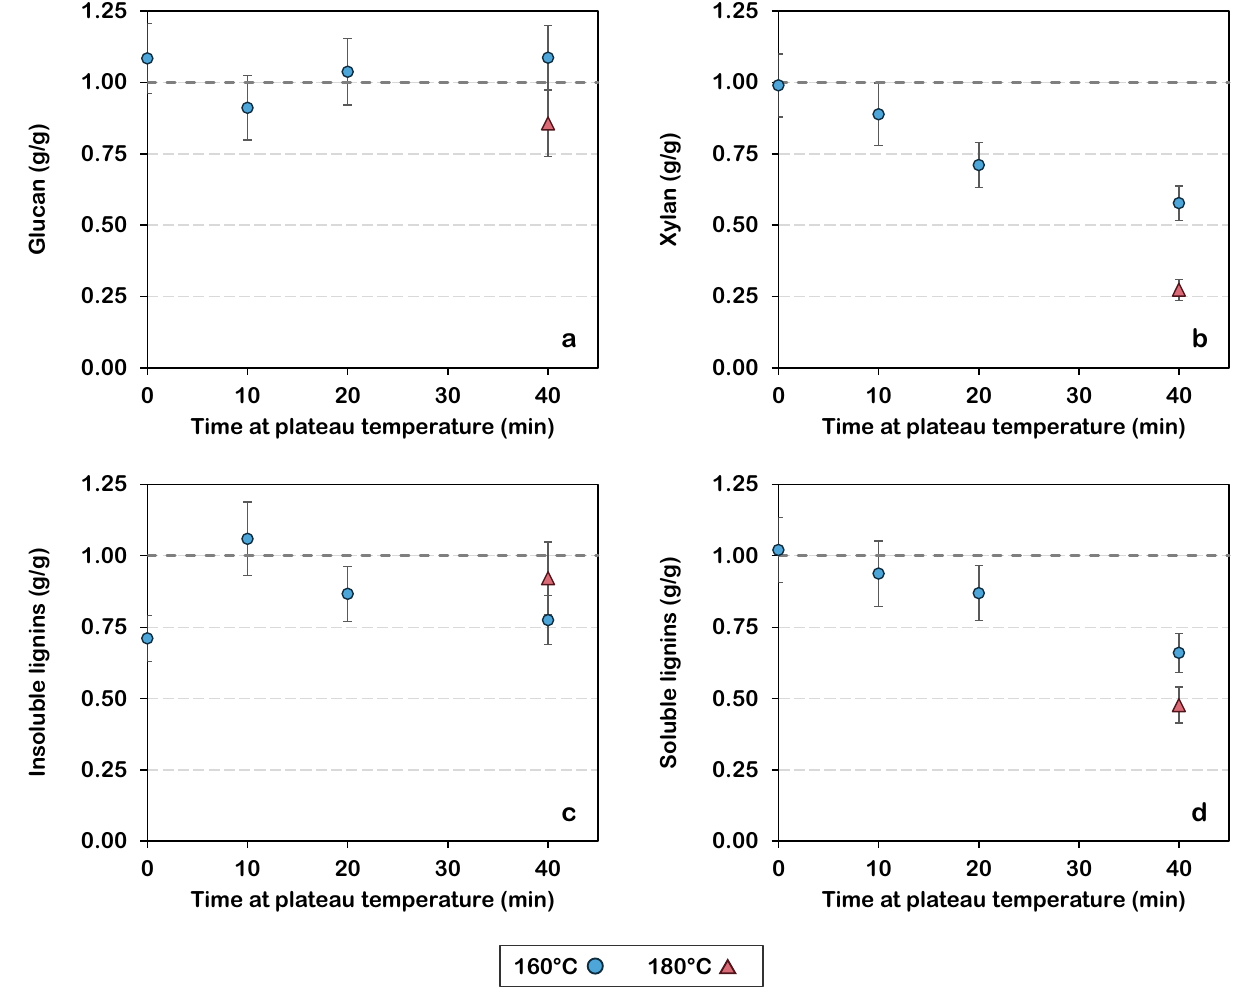
Figure 3. Relative amounts of ( a ) glucan, ( b ) xylan, ( c ) insoluble lignins and ( d ) soluble lignins of hydrothermally treated poplar as compared to its native